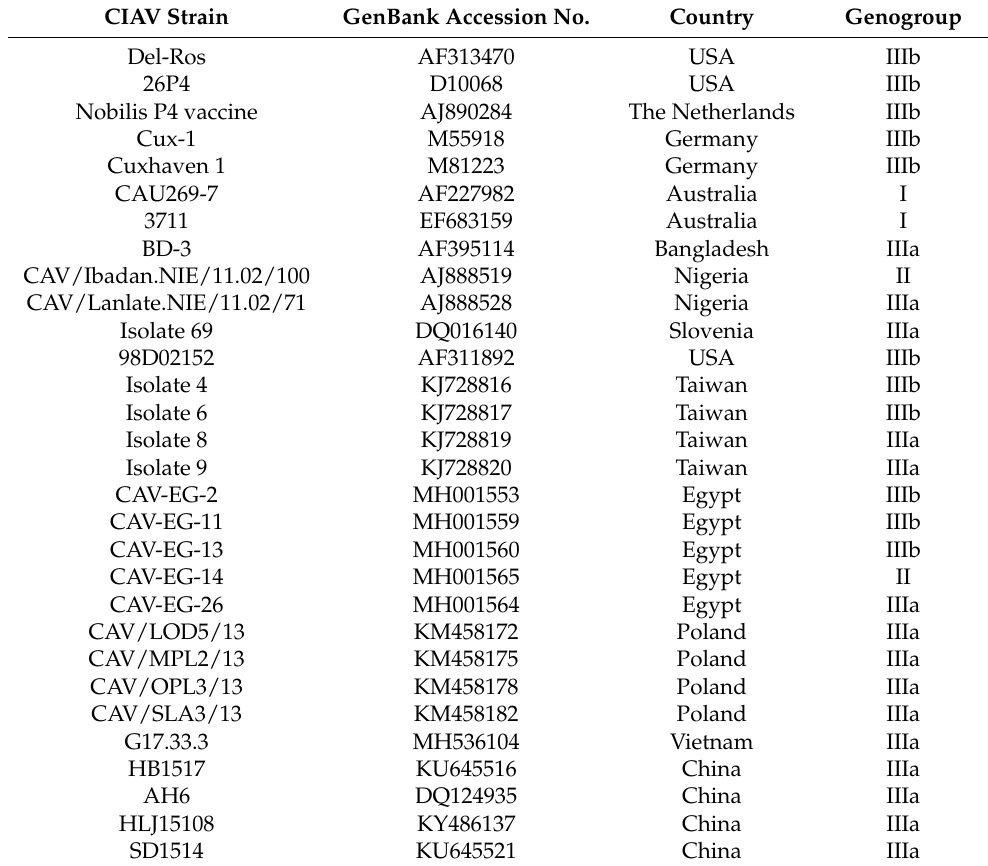
Table 1. CIAV sequences from GenBank included in this study. CIAV